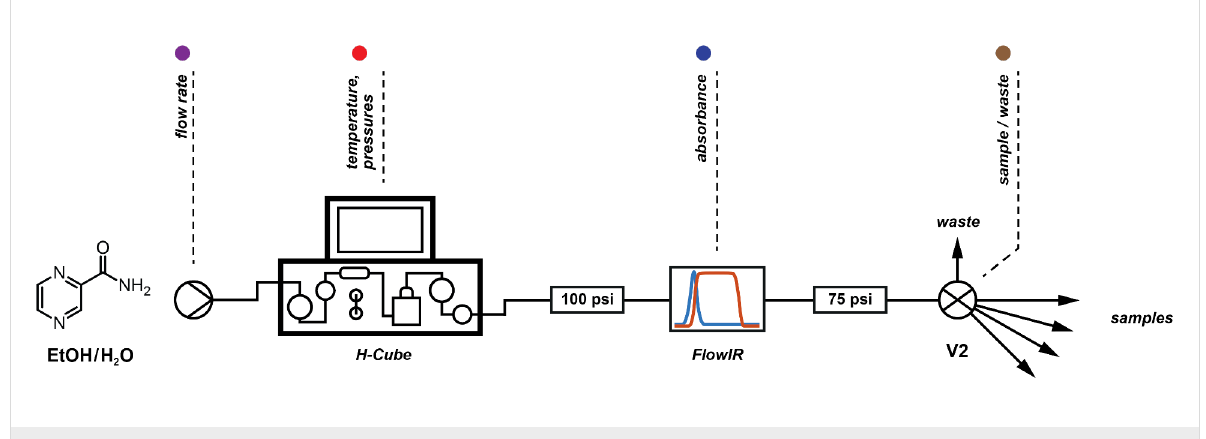
Figure 8: Reactor setup for optimisation reactions. A multi-position valve ( V2 ) was used for collecting samples.